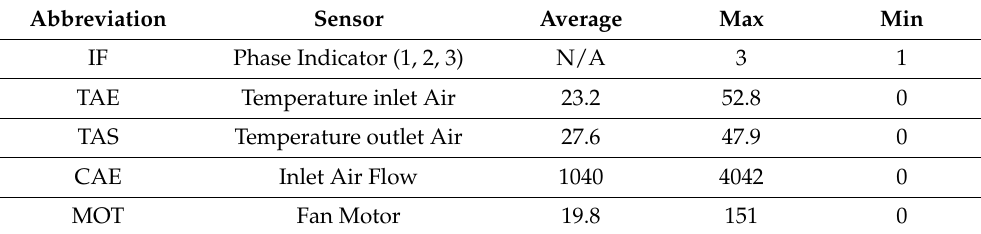
Table 2. Signals used for the